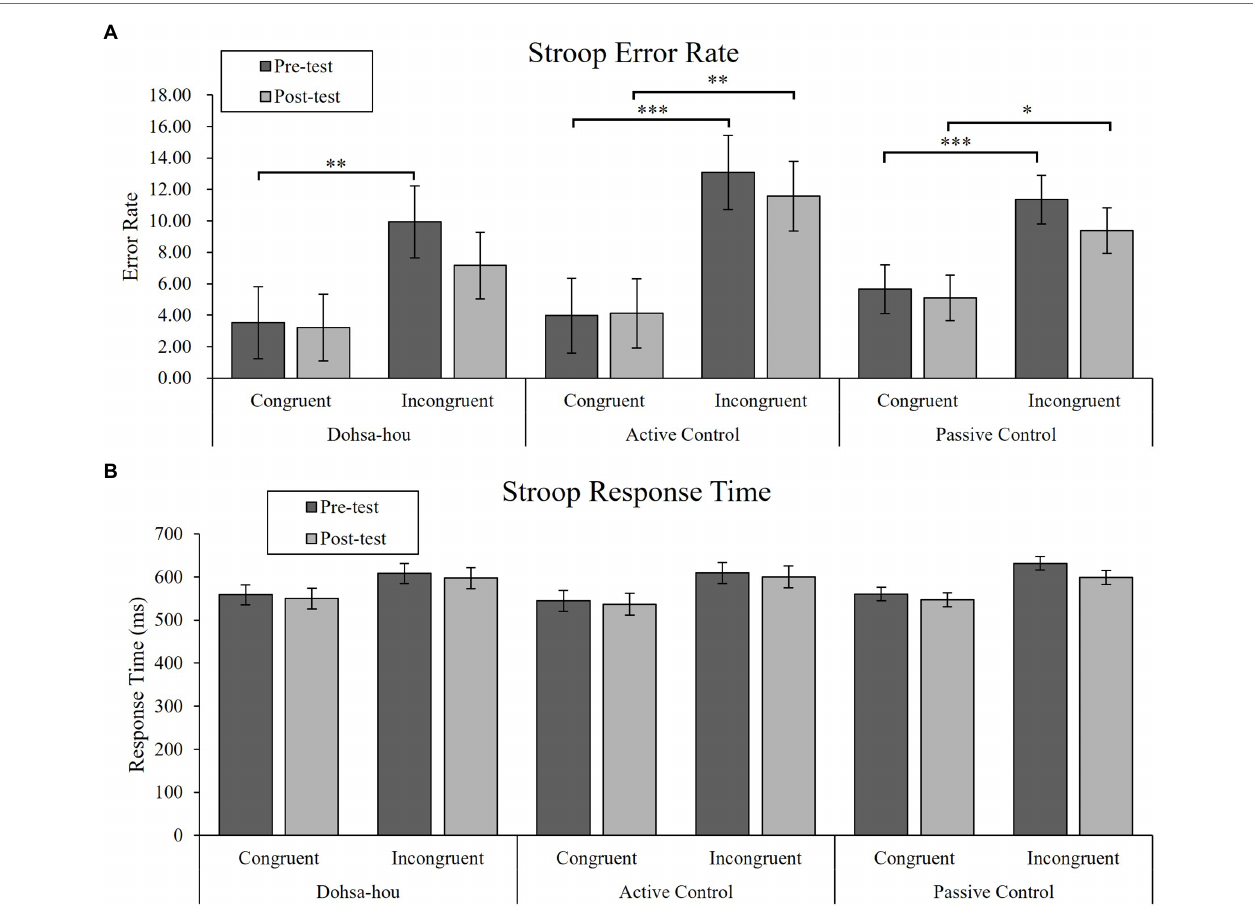
FIGURE 3 | The error bars represent standard error of the mean. (A) Mean error rate of the Modified Stroop Task for each group, each test time, and each trial type. (B) Mean response time of the Modified Stroop Task for each group, each test time, and each trial type. Asterisks represents a significant difference. ∗ p < 0.05; ∗∗ p < 0.01; ∗∗∗ p <